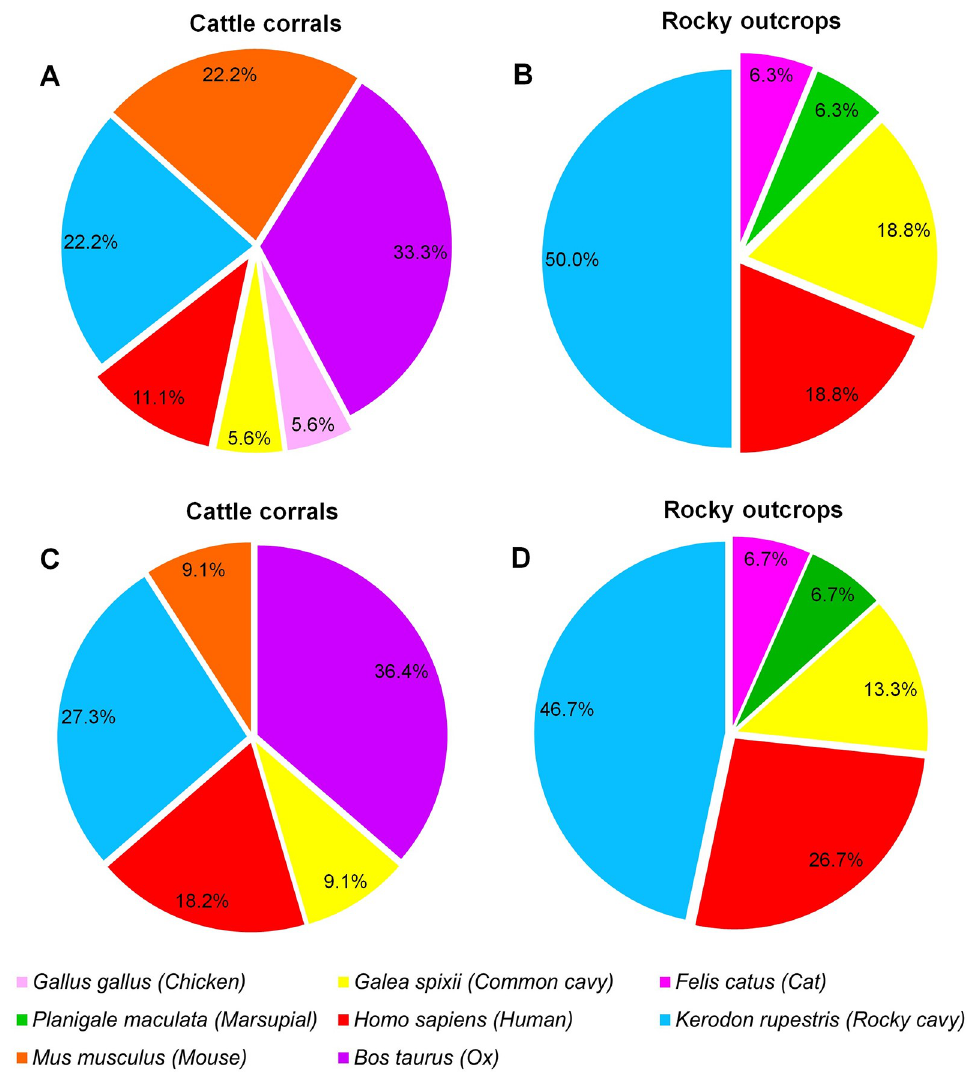
Fig 5. Blood meals sources of Triatoma b . brasiliensis identified in specimens from of cattle corral (peridomestic setting) and of rocky outcrops (sylvatic-d and sylvatic-c environments) from the Pedregulho, Ina´cio, S ã o Bernardo de Elias, and Riacho do Santo and the Batalh ã o de Engenharia de Construc¸ ã o localities in the Caico´ municipality, Rio Grande do Norte, Brazil. A-B. independent of T . cruzi positivity and C-D. of